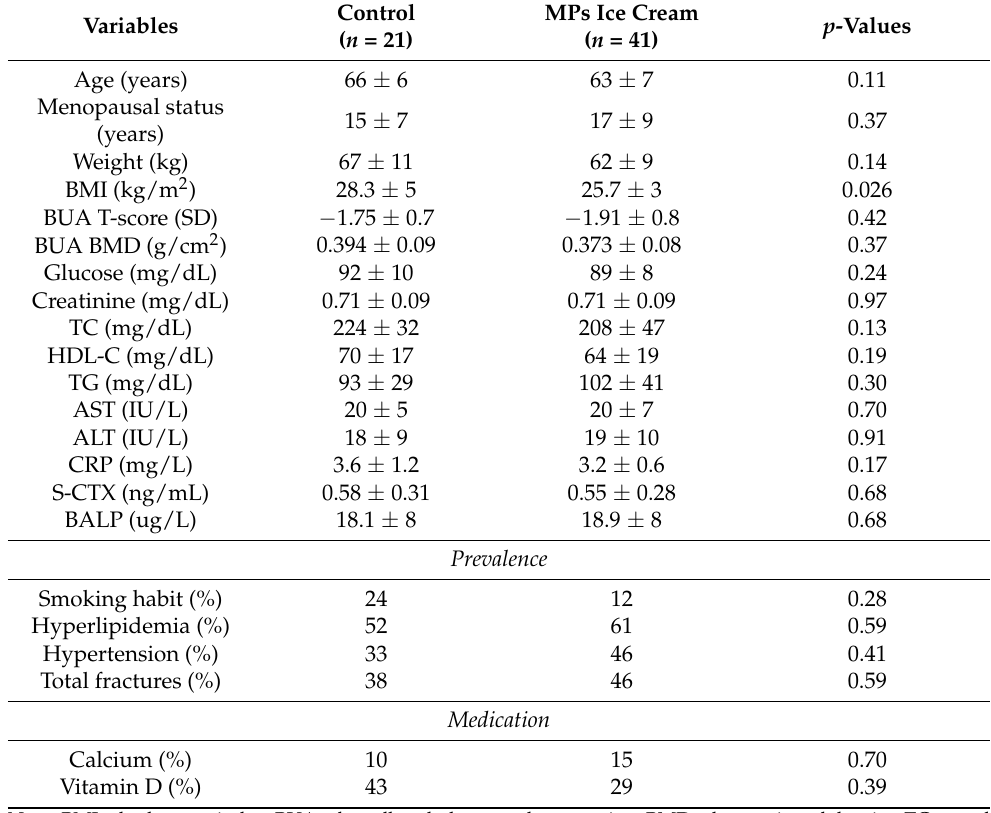
Table 1. Baseline demographic and clinical characteristics of participants according to